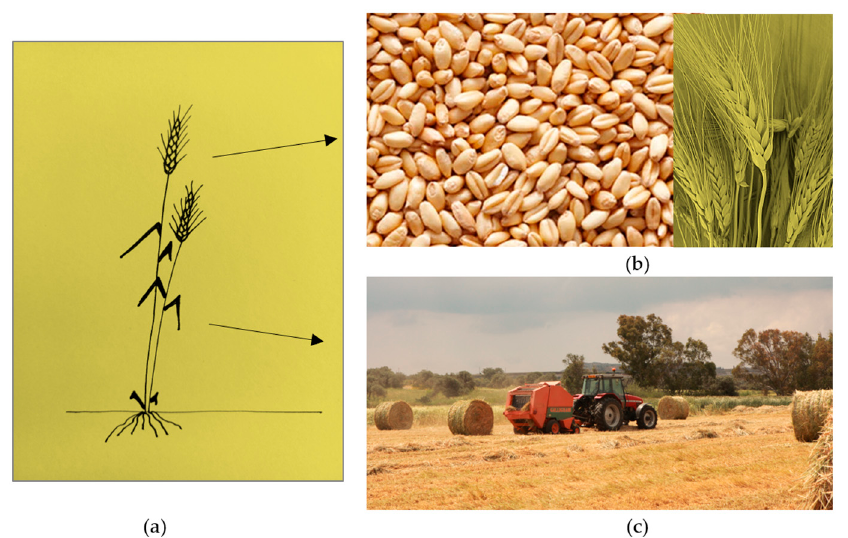
Figure 1. ( a ) Barley plant, ( b ) Seeds after harvesting, ( c ) Production of bale by a tractor. Photos taken by the authors.